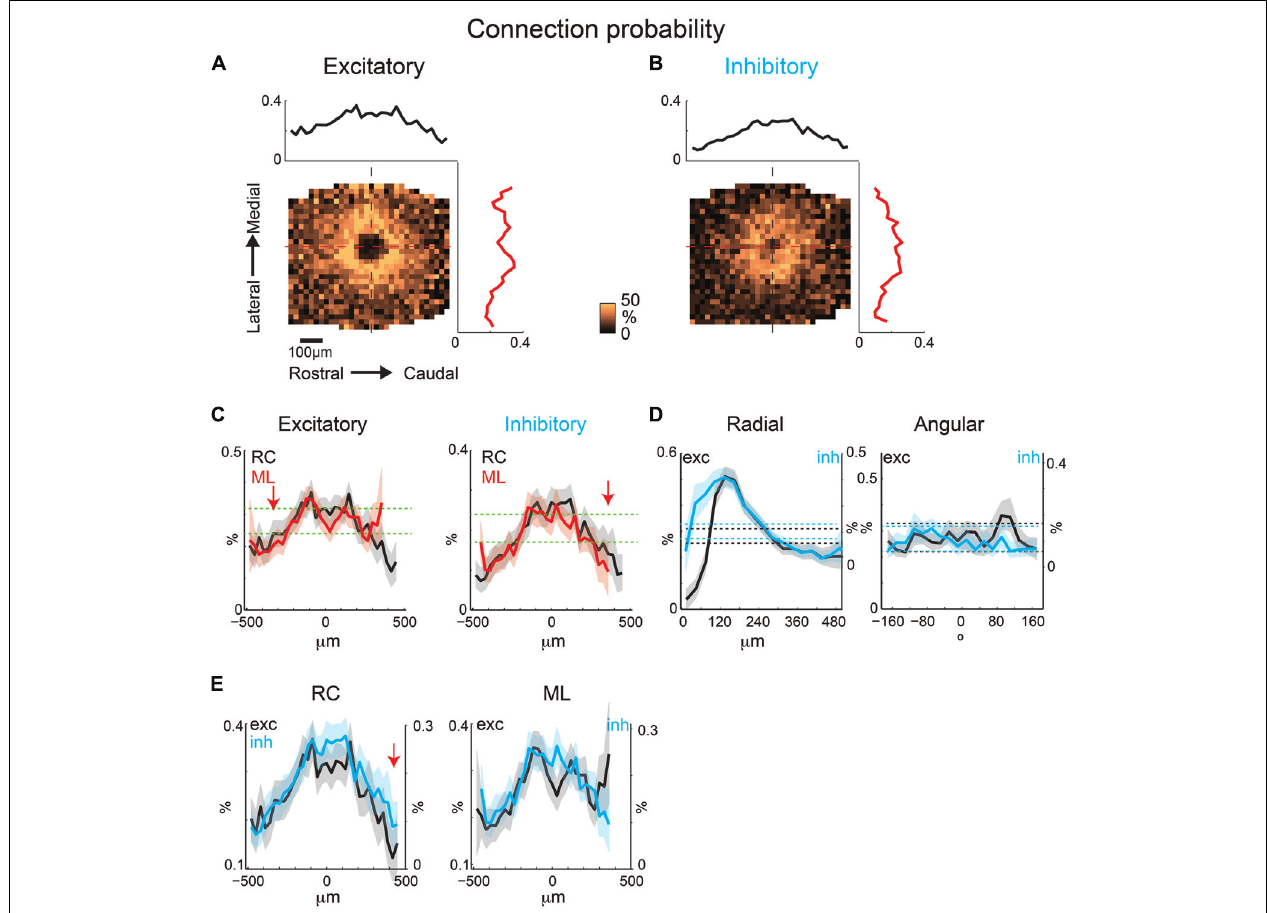
FIGURE 4 | Mean excitatory and inhibitory connection probability maps from a population of neurons recorded at 10 × magnification. Mean maps from a population of recorded neurons held at resting membrane potential ( A ; N = 26) and glutamate reversal potential ( B ; N = 24) generally demonstrate the 2D Gaussian connectivity profile. Plots above and to the right of the mean map indicate the marginal profile along the RC (tonotopic) and ML (isofrequency) directions, respectively. (C) ML and RC marginal profiles from (A,B) overlaid for excitatory (left) and inhibitory (right) inputs. Green dashed lines indicate the 95% confidence interval for the mean of the shuffled image. The shaded areas for this and subsequent plots